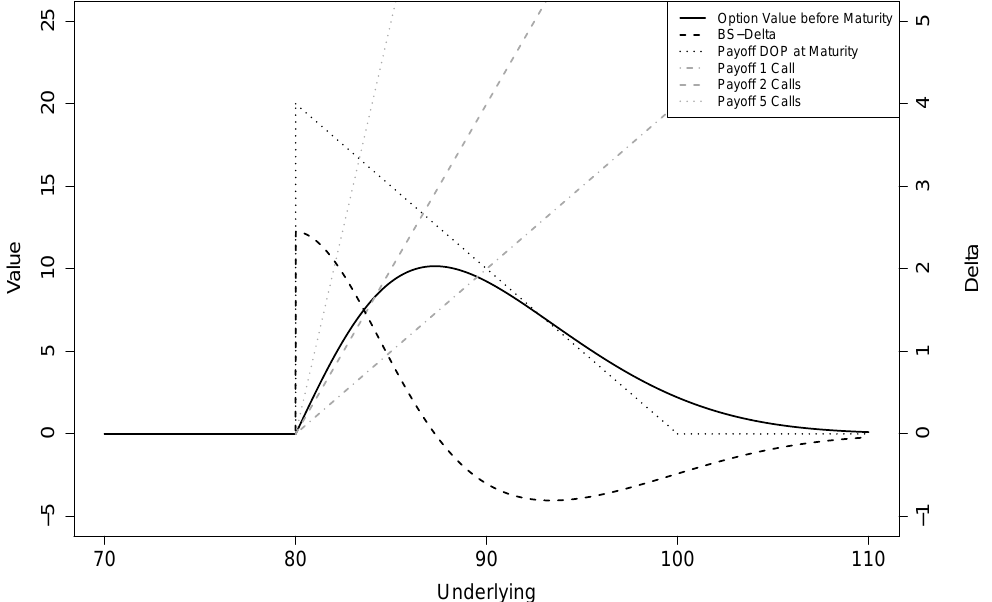
Figure 1. Value, Black–Scholes delta and payoff of a down-and-out put with strike price K = 100 and barrier B = 80, 20 days before maturity. Additionally, payoffs of 1, 2 and 5 vanilla call options with strike equal to the barrier of down-and-out put are